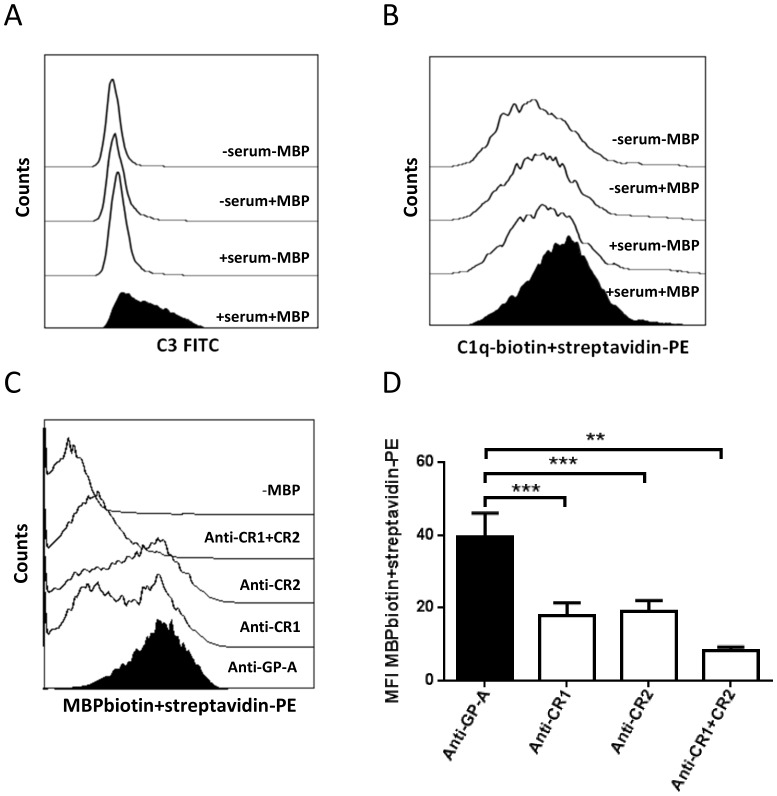
C1q and C3 co-deposit with MBP on B cells, which take up MBP via CR1 and CR2.PBMCs from healthy donors were incubated with or without 30 µg/ml MBP in medium containing normal autologous serum (30% v/v), or in pure medium. The resulting deposition of C3 and C1q on B cells was measured by flow cytometry after 5 min incubation (N = 3). Representative histogram plots show A) C3-deposition, and B) C1q-deposition on B cells. C) The binding of MBP was assessed using biotinylated MBP as probe and subsequent staining with streptavidin-PE. Blockade of CR1 or CR2 was achieved by pre-incubation of PBMCs with mAb3D9 and polyclonal sheep anti-human CR2 respectively. Monoclonal anti-glycophorin (GP)-A was used as negative control. D) Mean fluorescence intensity (MFI) values of 5–6 experiments are shown; background values (of samples with no MBP added) have been subtracted. Bars and error bars represent means and SEM. **p<0.01, ***p<0.001.